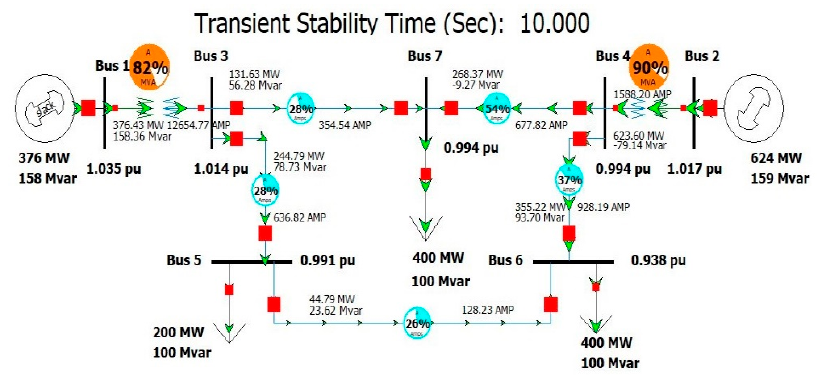
Figure 10. Transient stability power flow solution for first contingency scenario.